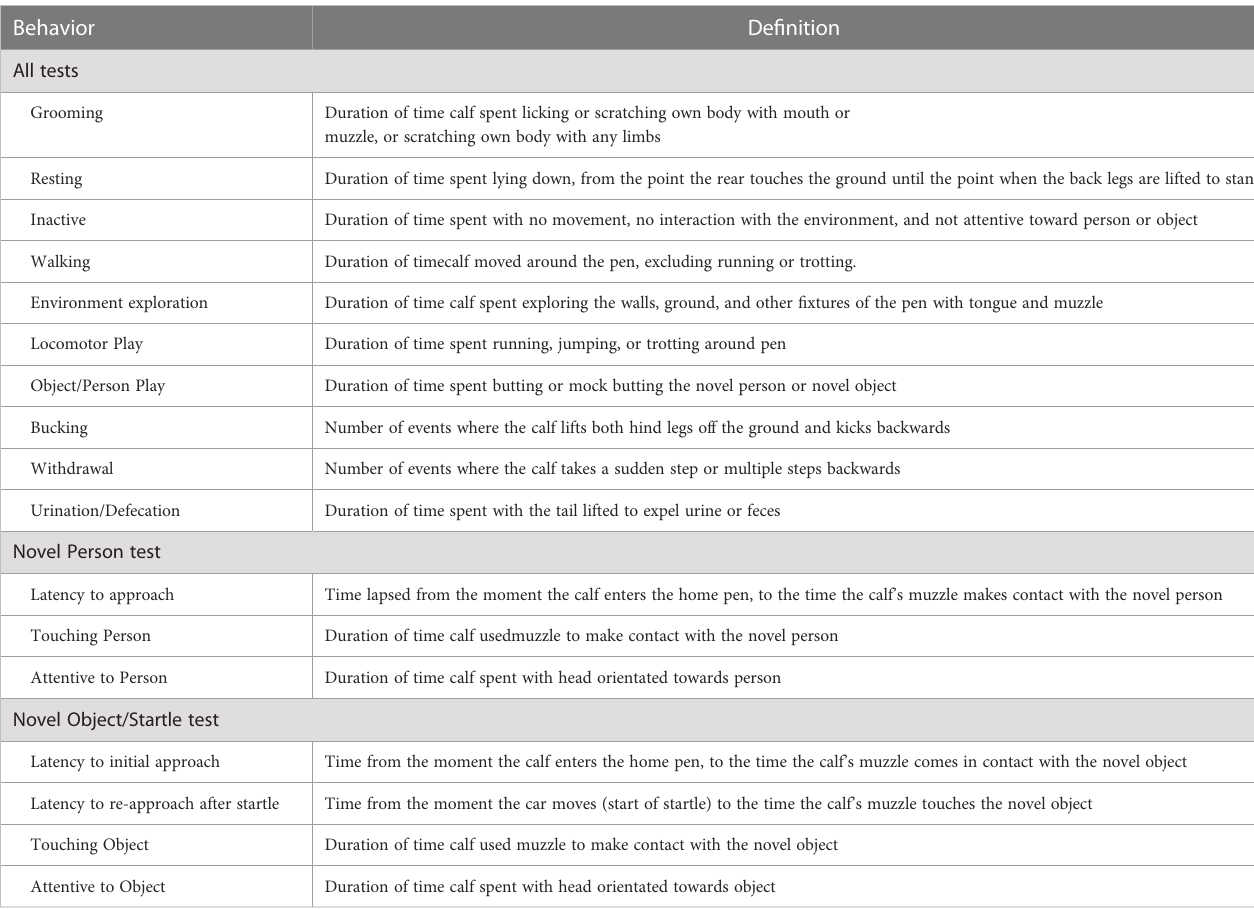
TABLE 1 Ethogram of behaviors recorded from the videos of the standardized personality tests (novel person, novel object, and startle tests) from individually housed Holstein x Angus crossbred calves (n = 29) tested in their home pen at 81.6 ± 2 d old. Behavior De fi